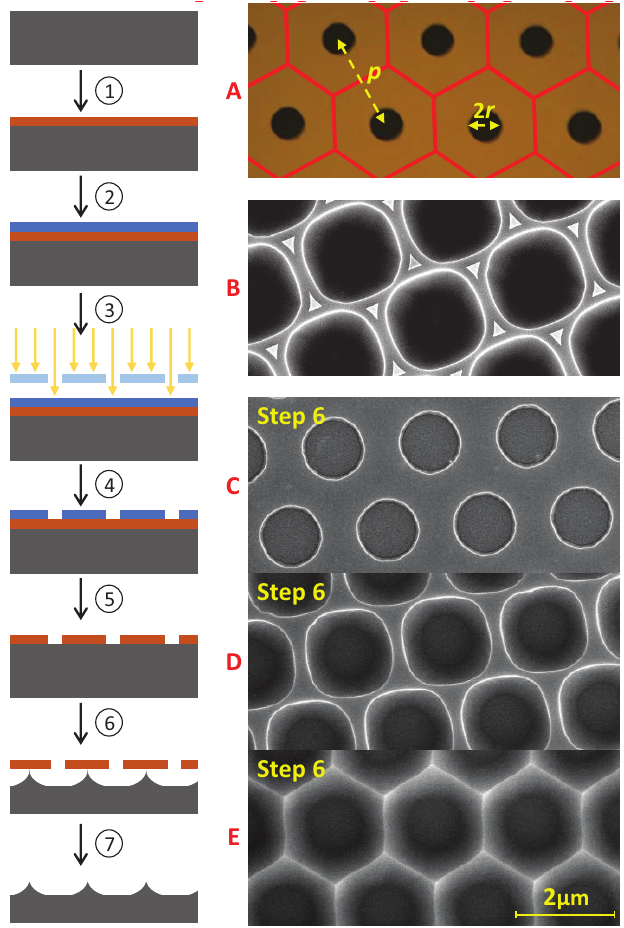
Fig. 2. Flowchart of the honeycomb texturing approach. A schematic representation of the silicon surface and additional layers phase is presented on the left. Processing steps 1 – 7 are referenced in the text. Visual A. is optical microscope image of the mask used for exposure. Red lines are added to indicate the honeycomb structure resulting from the used mask. Visual B – E are SEM images at 0 degrees tilt, Visual B indicates the effect of under-etching at step 4. Visuals C – E indicate the effect of etching time during step 6.